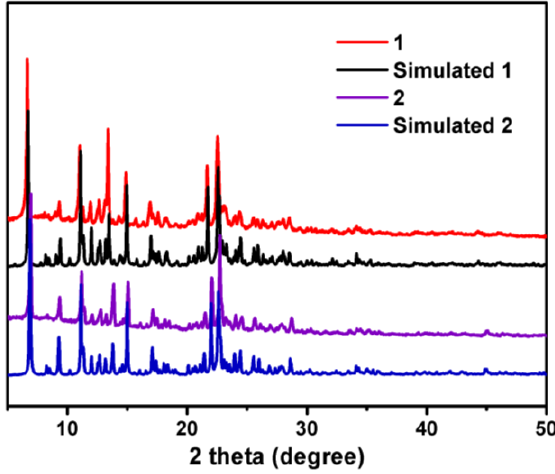
Figure 5. Powder X-ray diffraction (PXRD) patterns of complexes 1 and 2 .